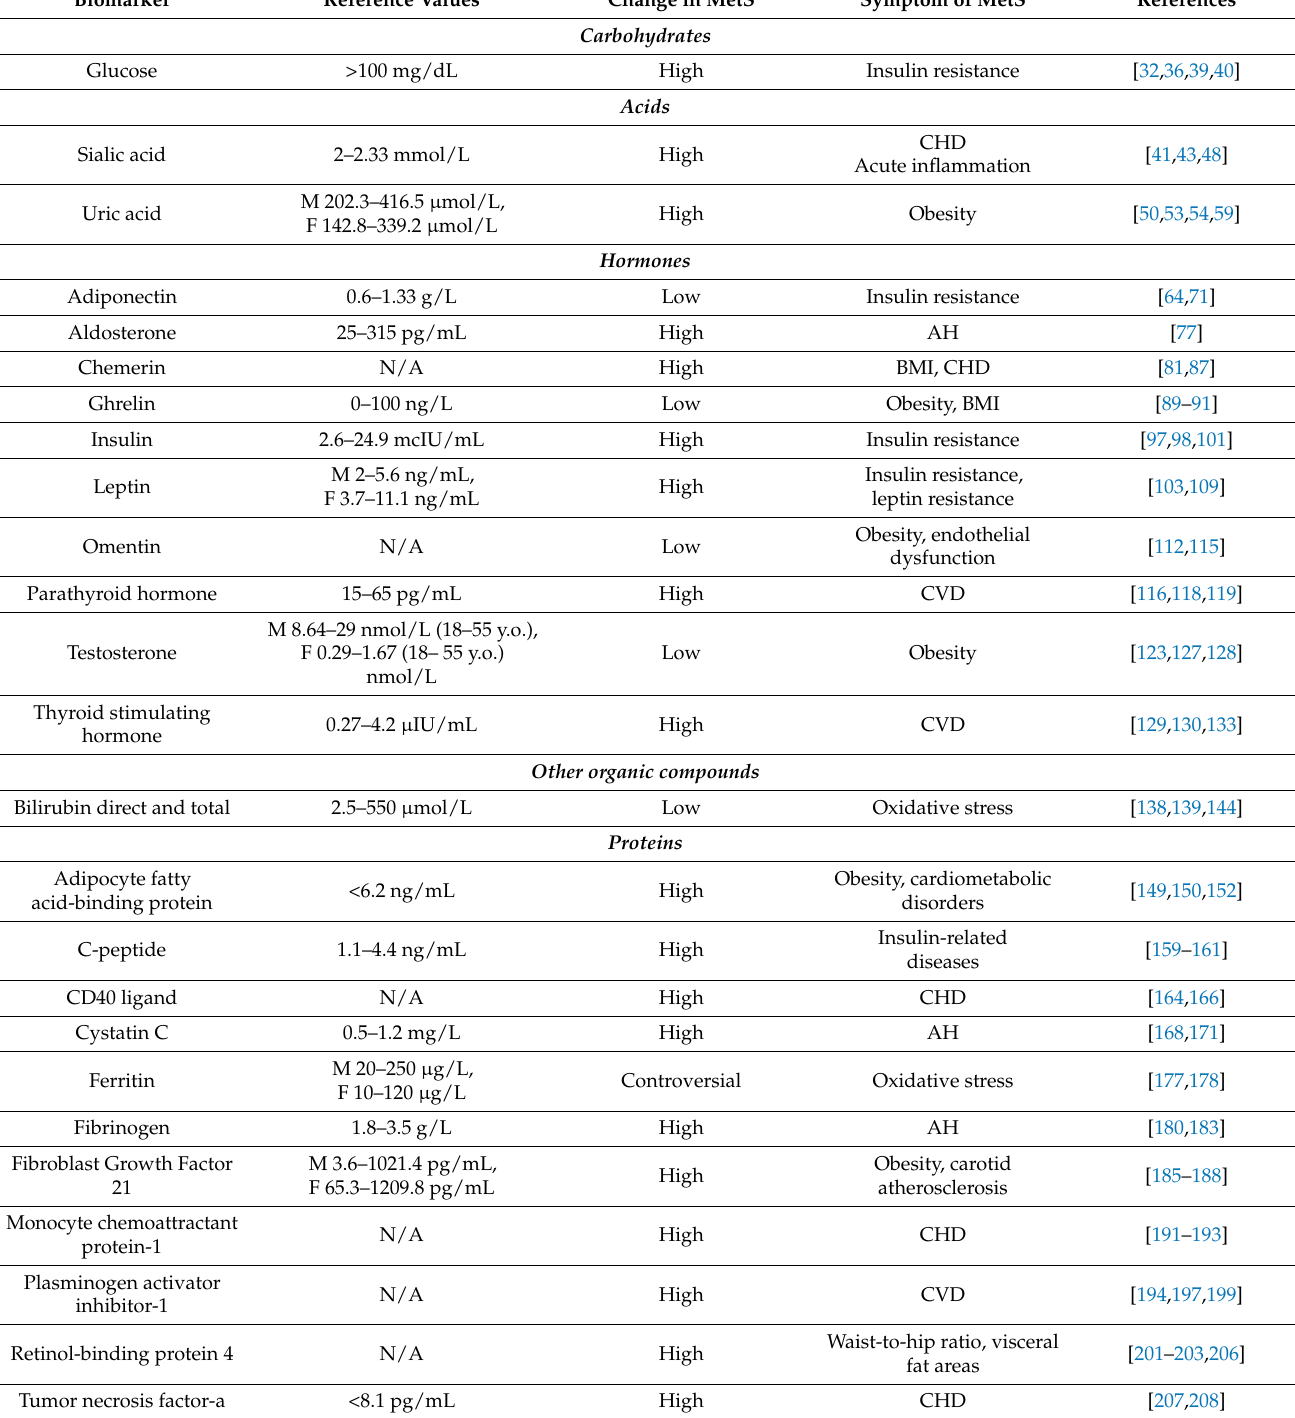
Table 1. Potential Serum and Plasma Biomarkers of Antipsychotic-Induced Metabolic